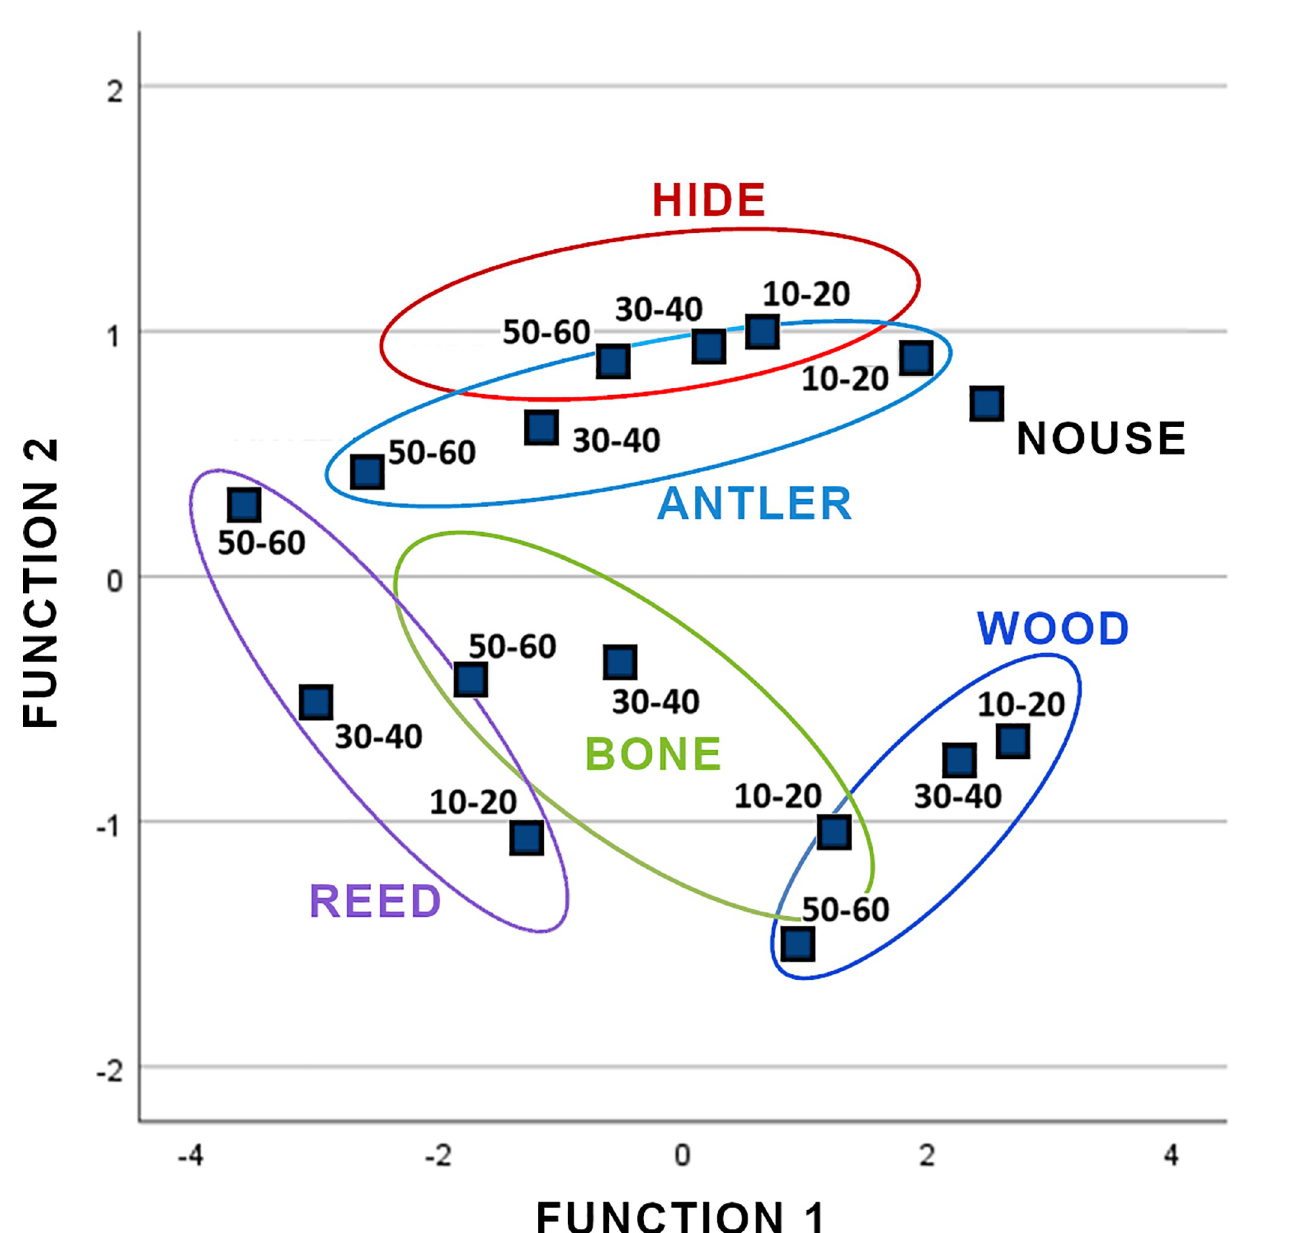
Fig 8. Plot with the two best functions of the quadratic discriminant analysis. Points represent centroids of the 16 groups of worked materials/time of use plus unused surfaces. Function 1 explains 62.6% of the variance and Function 2 10.6%. minutes (overlapping with antler). In a second classification between wood and no use for the samples used for 10 minutes, the classification is still ambiguous (50% for no use and 50% for wood). The second classification between wood and antler for 20, 40 and 50 minutes yields correct classifications (S1-6a, S1-6b in S1 Data). Conversely, the classification of the hafted tool against the 16 groups (material/time plus no use) is correct for woodworking from 10 to 60 minutes. These results indicate that the hafted tool develops more polish, resulting in better classification of the tool (S1-7 in S1 Data). In conclusion, considering both the time of use and the worked material, a better identification of the worked material is reached.